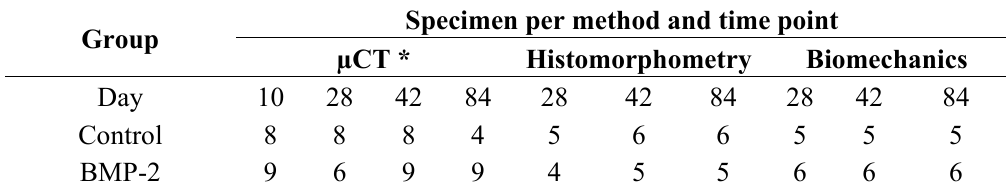
Table 1. Number of animals and investigated parameters of the osteotomized tibia at the different post-operative time points. Specimen per method and time point Group µCT